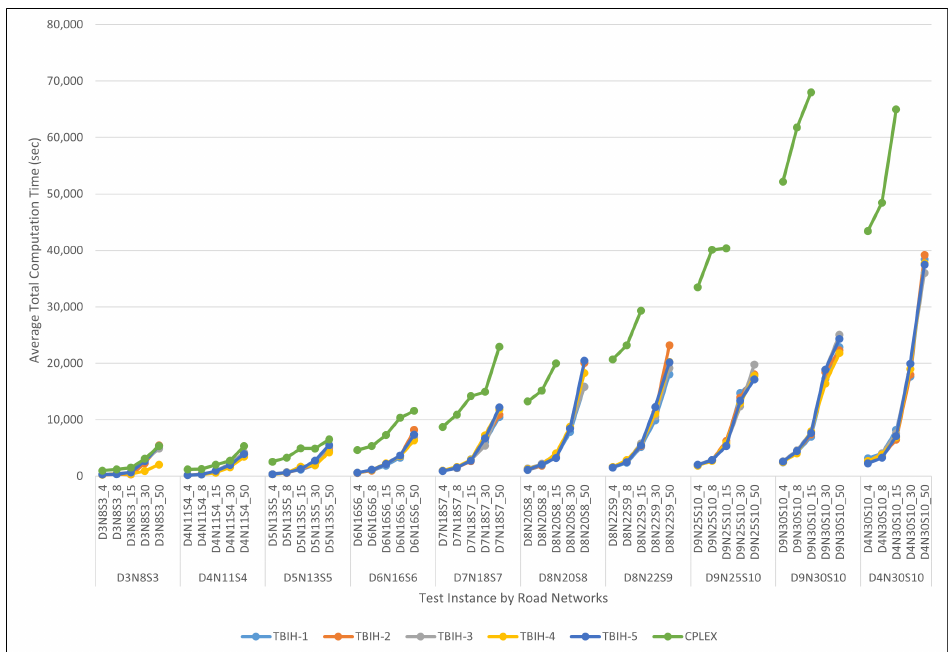
Figure A14. Algorithms performance compared to matheuristic rollout applied in PDS-RA: average total computation time (sec) based on test instances.